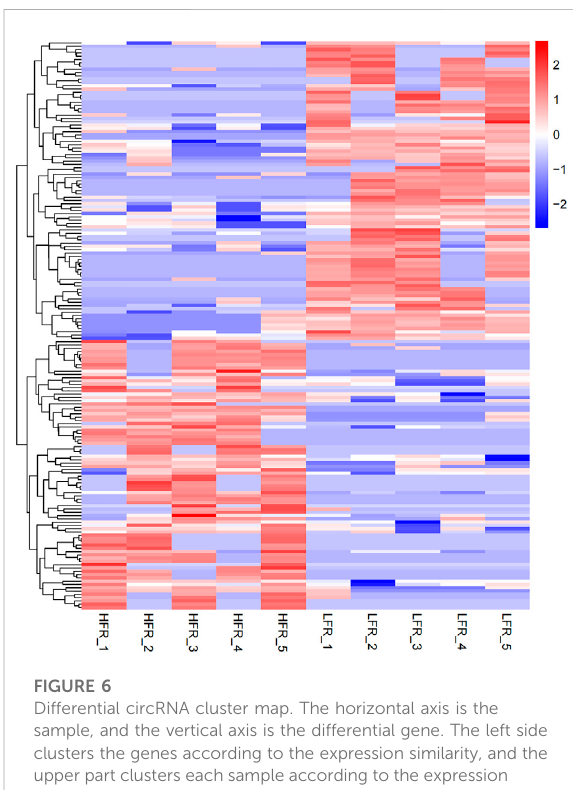
FIGURE 6 Differential circRNA cluster map. The horizontal axis is the sample, and the vertical axis is the differential gene. The left side clusters the genes according to the expression similarity, and the upper part clusters each sample according to the expression pro fi le similarity. The expression level gradually increases from blue to red, and the number is the relative expression level after